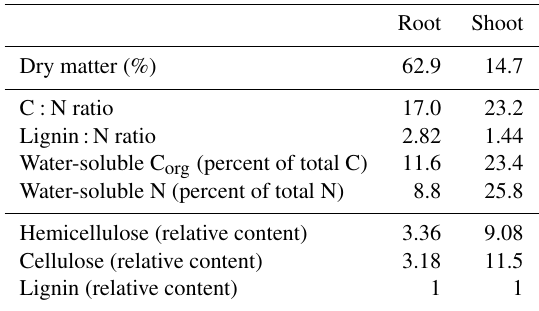
Table 2. Chemical characteristics of maize root and shoot litter used in the incubation experiment. Hemicellulose and cellulose are ex- pressed relative to lignin